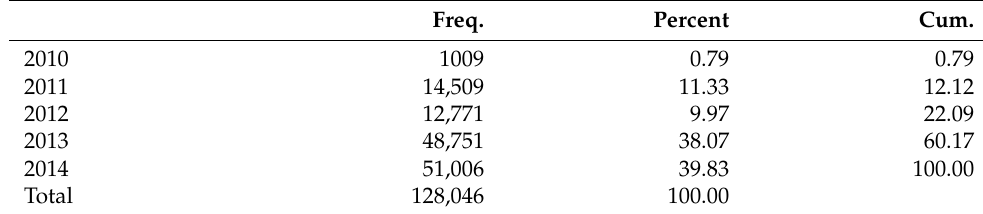
Table A3. Loan Application Distribution by Year. Freq.